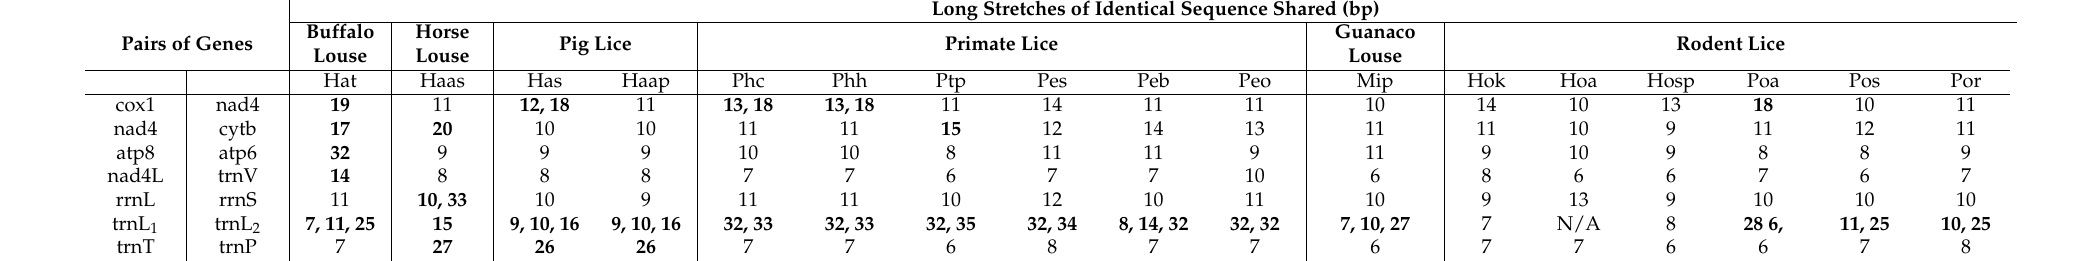
Long Stretches of Identical Sequence Shared (bp)